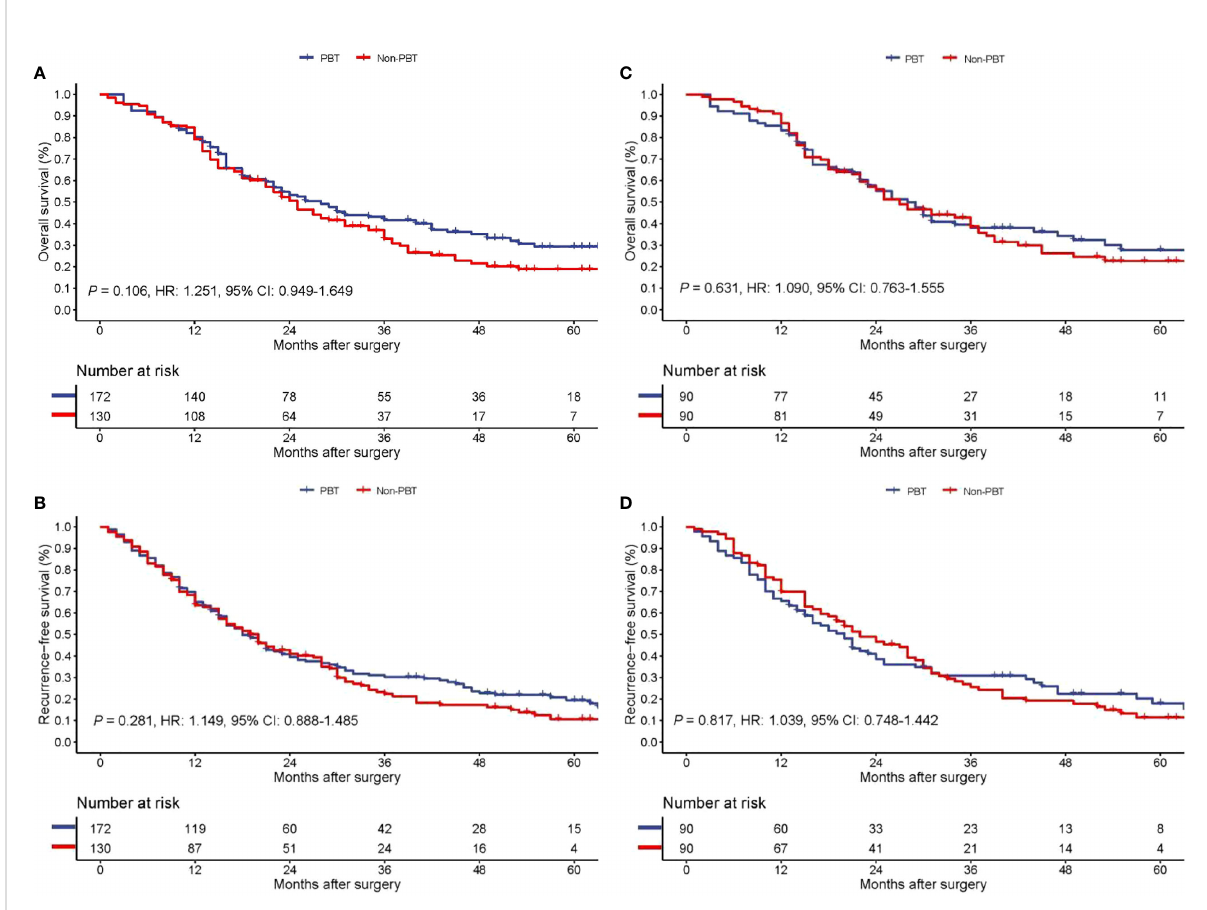
FIGURE 1 Kaplan − Meier curves of overall survival (A) and recurrence-free survival (B) between the PBT and non-PBT groups among all pCCA patients treated with curative resection before PSM. Kaplan − Meier curves of overall survival (C) and recurrence-free survival (D) between the PBT and non-PBT groups among all pCCA patients treated with curative resection after PSM. CI, con fi dence interval; HR, hazard ratio; PBT, perioperative blood transfusion; PSM, propensity score